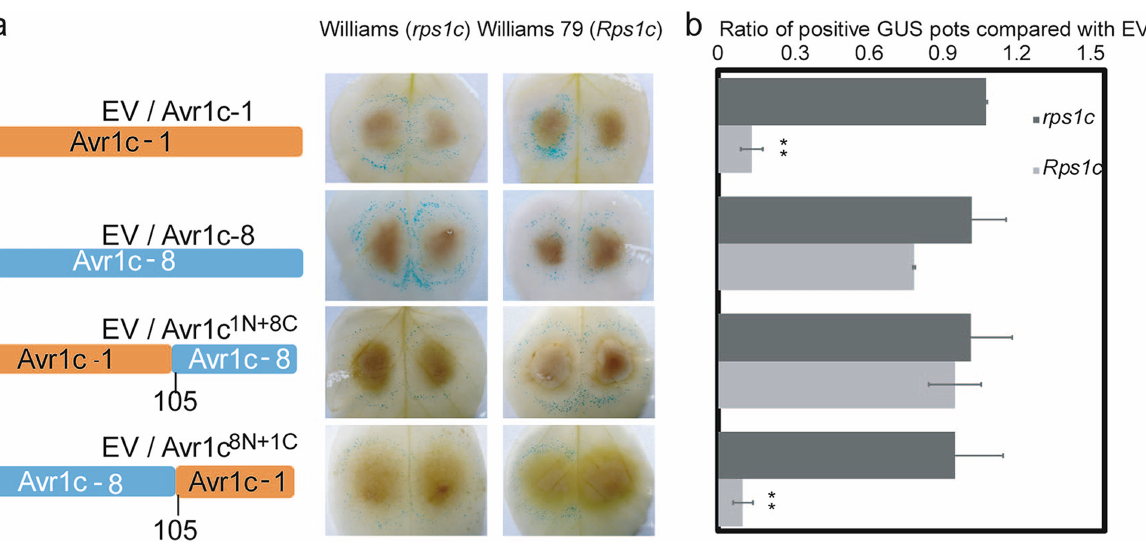
Fig. 5 C-terminal of Avr1c is critical for recognition by Rps1c . a The wild-type and mutants transiently expressed in rps1c and Rps1c leaves. The blue pots (surviving cells) of rps1c and Rps1c leaves transiently expressing Avr1c 1N+8C , Avr1c 8N+1C , and the wild-type. b Ratio of GUS-positive blue spots following bombardment with Avr1c variants and mutants compared to EV. Bars represent standard errors from three independent replicates. **, P < 0.01 by t